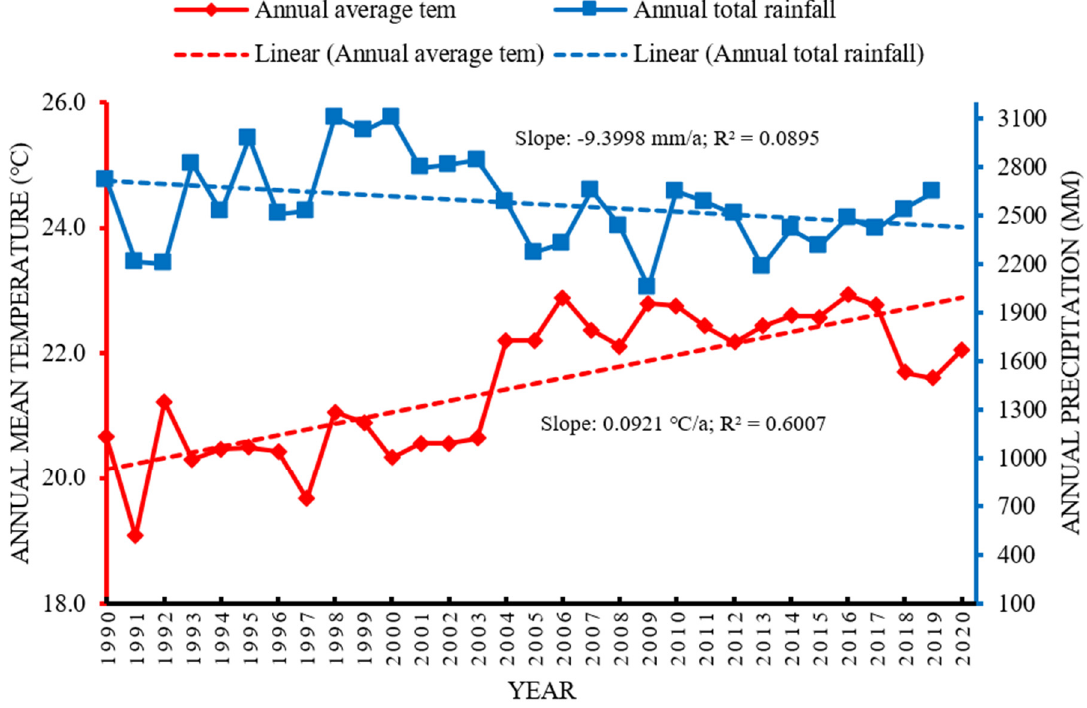
Figure 3. Temperature and precipitation trend in Hill region of the